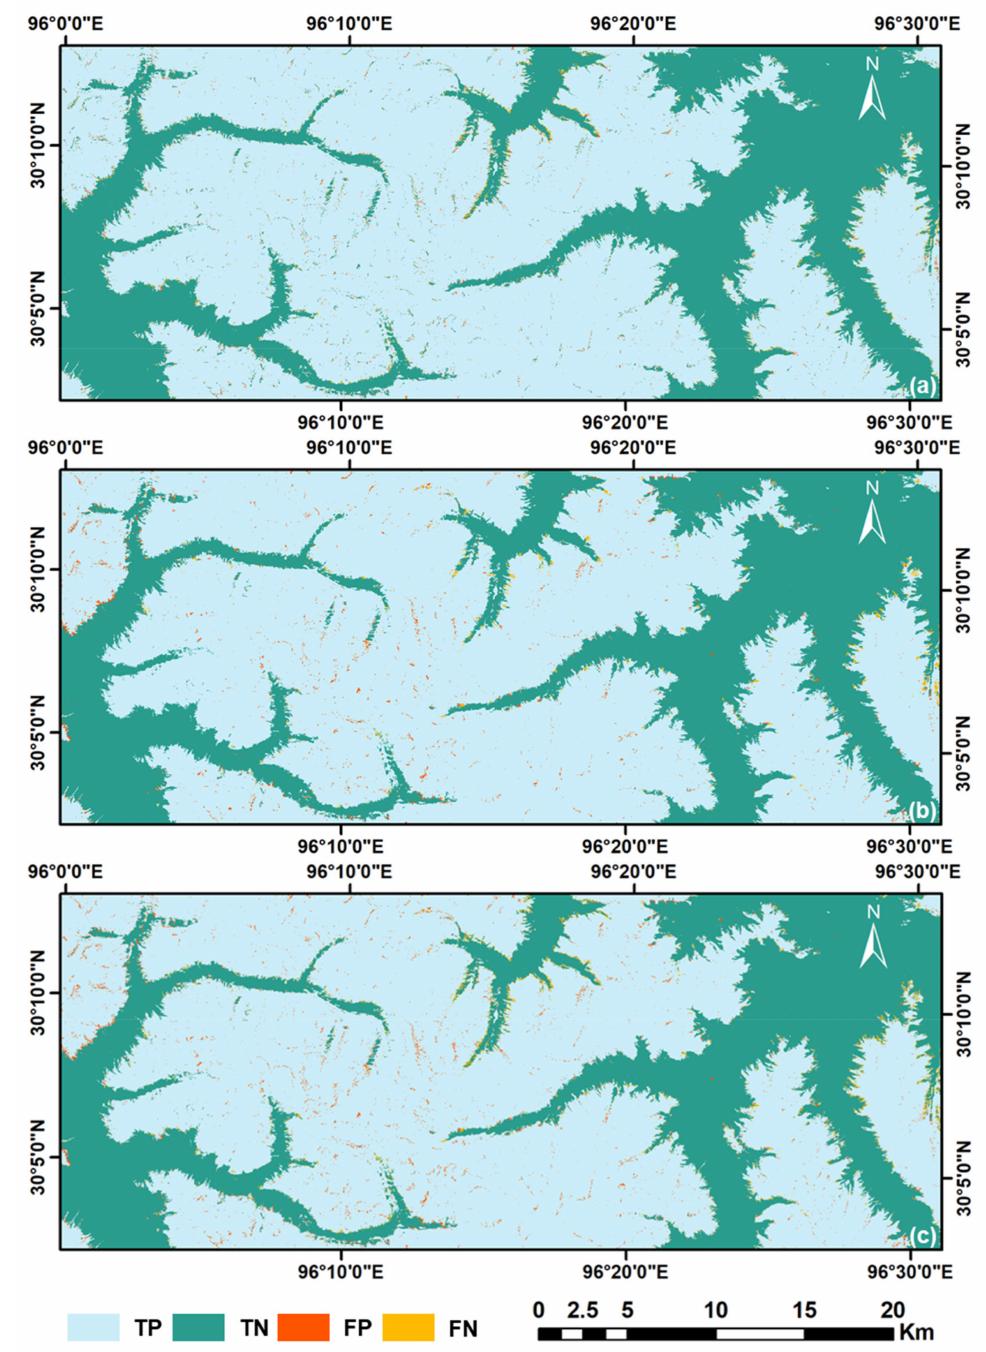
Figure 8. Results of pixel classification using different snow covers as predictions and ground truths: ( a ) object-based snow cover as prediction and pixel-based snow cover as ground truth, ( b ) snow cover predicted by the random forest model as prediction and object-based snow cover as ground truth and ( c ) snow cover predicted by the random forest model as prediction and pixel-based snow cover as ground truth. (TP: true positive; TN: true negative; FP: false positive; and FN: false